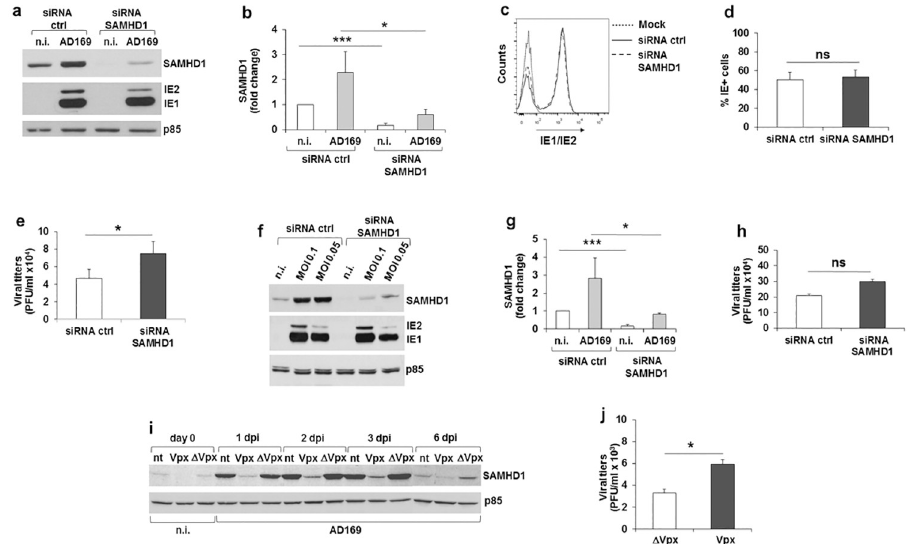
Fig 3. SAMHD1 knock-down by siRNA or Vpx expression and effect on HCMV replication. a-h) HFFs were transfected with SAMHD1 siRNA or non-targeting siRNA (ctrl). Two days later, cells were either infected with AD169 at an MOI of 1 and harvested at 3 dpi (a-e) or infected at an MOI of 0.1 or 0.05 and harvested at 6 dpi (f-h). a) Levels of SAMHD1 and IE1/IE2 viral protein expression were assayed by immunoblotting. The p85 subunit of PI3K was used as loading control. One representative experiment is shown. b) The relative amount of SAMHD1 protein, normalized to that of p85, was determined by densitometric analysis and is relative to that of n.i./siCtrl cells, which was arbitrarily set as 1. Data are expressed as mean ± SE. c) The percentage of IE+ cells was analyzed by FACS after intracellular staining with a specific anti-IE1/IE2 mAb. FACS plots derive from one representative experiment. d) The percentage of IE + cells is expressed as mean ± SD, as detected by FACS. e) Cell culture supernatants were assayed for infectious virus production by plaque assays. Results are expressed as mean ± SE. All data in panels a-e derive from five independent experiments. f) Immunoblotting at 6 dpi was performed as described in panel a). One representative experiment out of two is shown. g) The relative amount of SAMHD1 protein was determined as in panel b). Data are expressed as mean ± SE of two independent experiments with cells infected at both MOI. h) Viral titers were measured and expressed as in panel e) and derive from cell culture supernatants of two independent experiments, were HFFs were infected at an MOI of 0.1 or MOI of 0.05 for 6 days. i-j) HFFs were infected with single-cycle VLPs loaded with Vpx (Vpx) or unloaded ( Δ Vpx) at an MOI of 1, and then the same cells were infected with AD169 at an MOI of 1. At different dpi, cells and supernatants were harvested and subjected to immunoblotting and plaque assays, respectively. i) Immunoblotting of SAMHD1 protein expression. One representative experiment out of three is shown. j) Cell culture supernatants were assayed for infectious virus production by plaque assays. Results are expressed as mean ± SE of four experiments at 2–3 dpi. nt, not treated; n.i., not infected cells; � , p < 0.05; ��� , p < 0.001; ns, not significant.